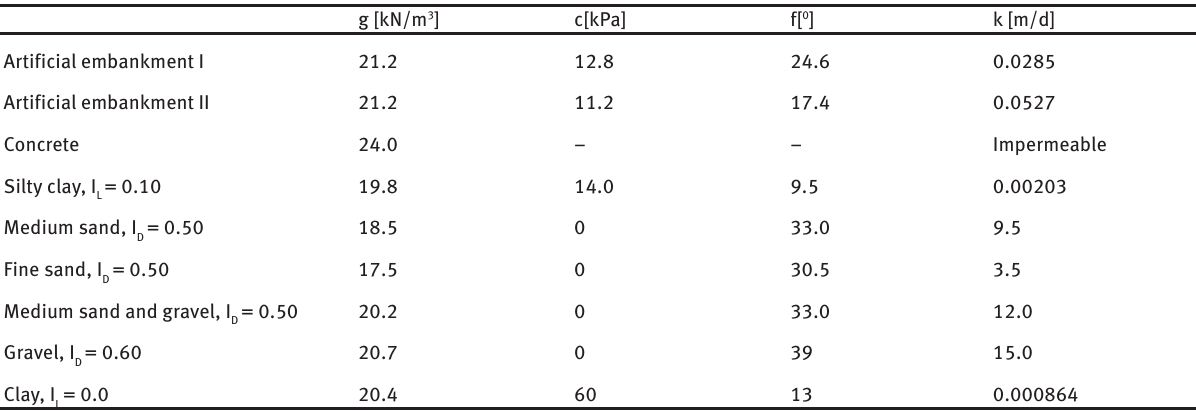
Fig. 13 Failure mode, before the flood and in the descending phase of the flood.